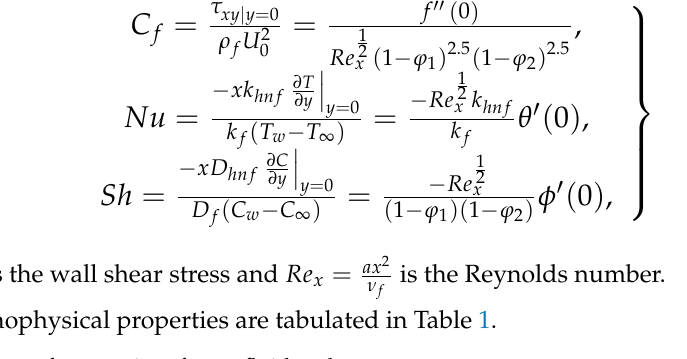
Table 1. Values of properties of pure fluid and nanostructure. Physical